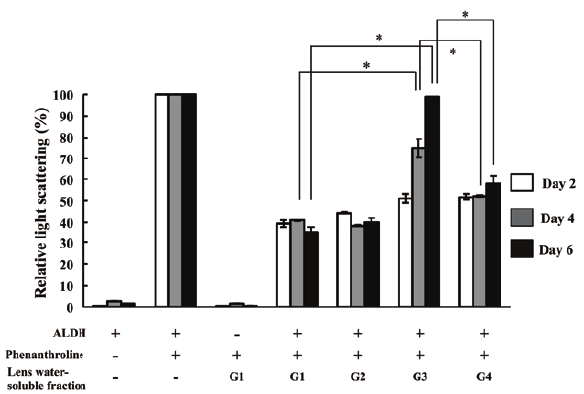
Figure 4: Relative change of light scattering. The change of ALDH scattering during 180 min after adding 1,10-phenanthroline at 42°C was calculated. The change of ALDH scattering in the sample without lens water-soluble fraction indicates for as 100% in the bar graph. The scatterings were measured on day 2 (white bar), day 4 (gray bar), and day 6 (black bar) following selenite or placebo admi- nistration. Bar represent mean values (n = 9 lenses in each group) and error bars represent S.E. * indicates P < 0.05 for significant